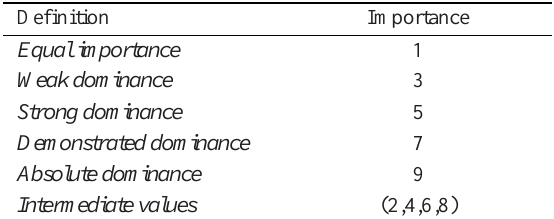
Table 1 . Saaty’s comparison scale